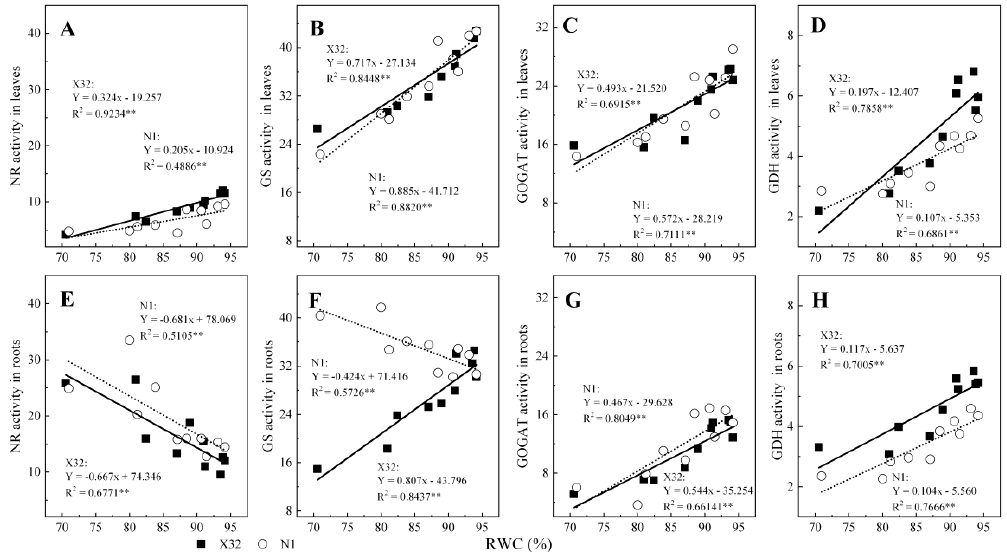
Figure 12. Relationship between NR, GS, GOGAT or GDH activities with the leaf relative water content in leaves ( A , B , C and D ) and roots ( E , F , G and H ) for the two sweet potato. The solid and dotted lines represent X32 and N1, respectively.